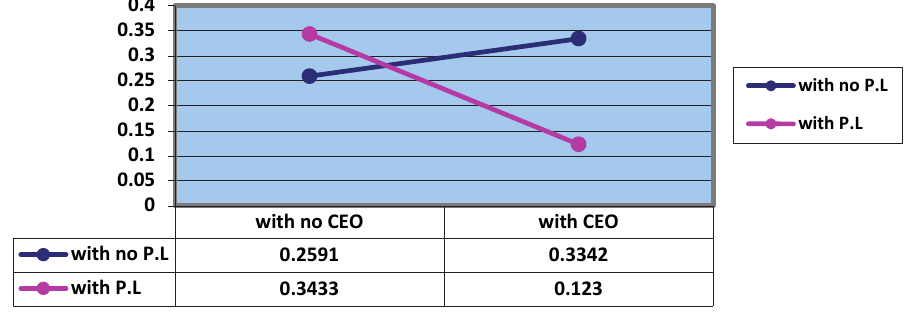
Fig. 1. The Interaction Effect of CEO-Duality on CER Information Under the Moderating Influence of Corporate Political Links